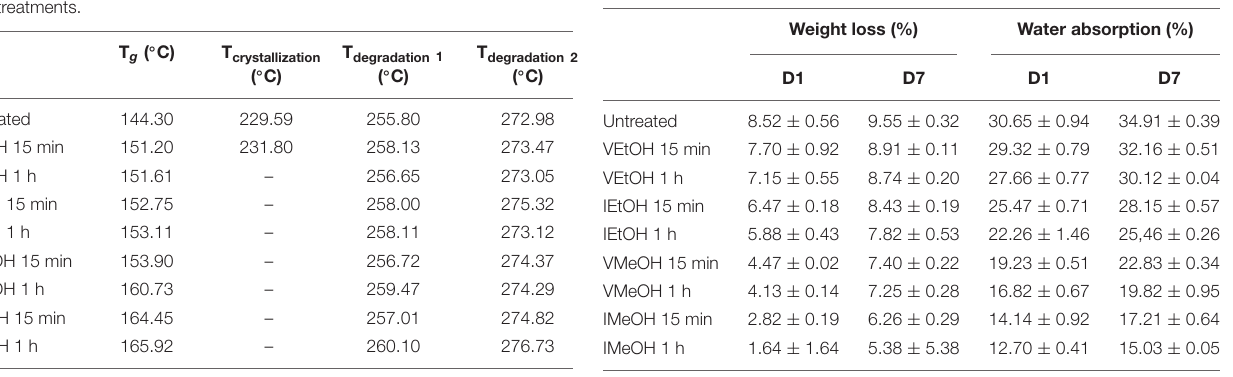
TABLE 5 | Results of weight loss films and water absorption films of